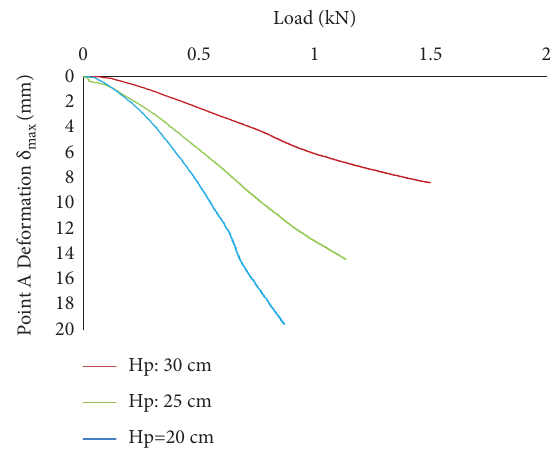
� 2B/3, B, 4B/3. p in case of L